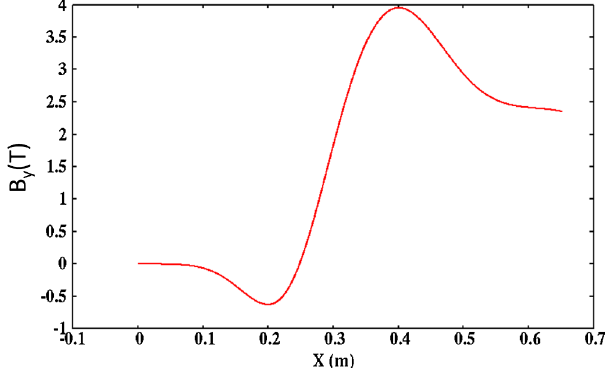
FIG. 2. Vertical magnetic field middle plane distribution after attaining the longitudinal synchronous conditions (Table I).